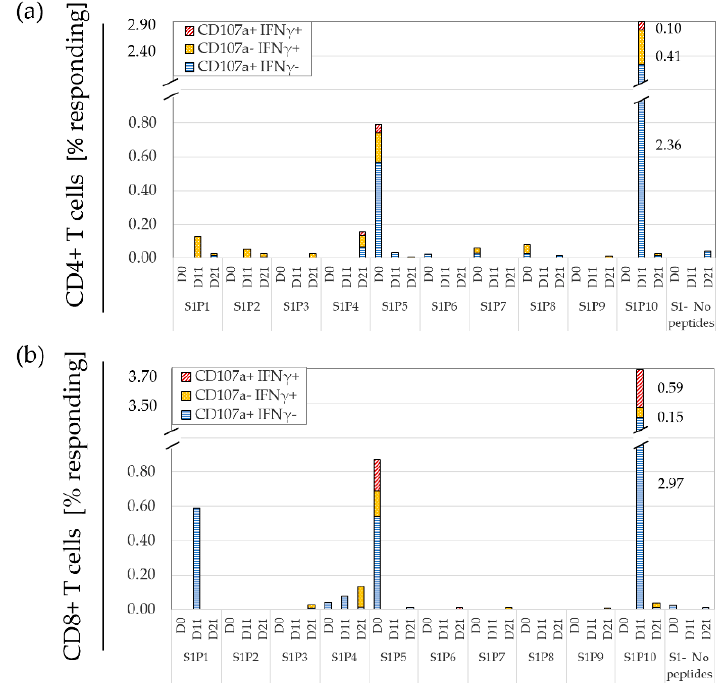
Figure 6. The use of early activation markers enables detection of weak responses to peptides. A glioma patient’s PBMC were cultured with or without peptides overnight then stained and analyzed using the Activation marker-inclusive FCM approach (A-FCM). Shown are mono- and polyfunctional responses (IFN γ /CD107a) of CD4 ( a ) and CD8 ( b ) T cells responding to set 1 peptides. These T cells have also expressed one or more early activation markers - 4-1BB or CD40L (representative results).